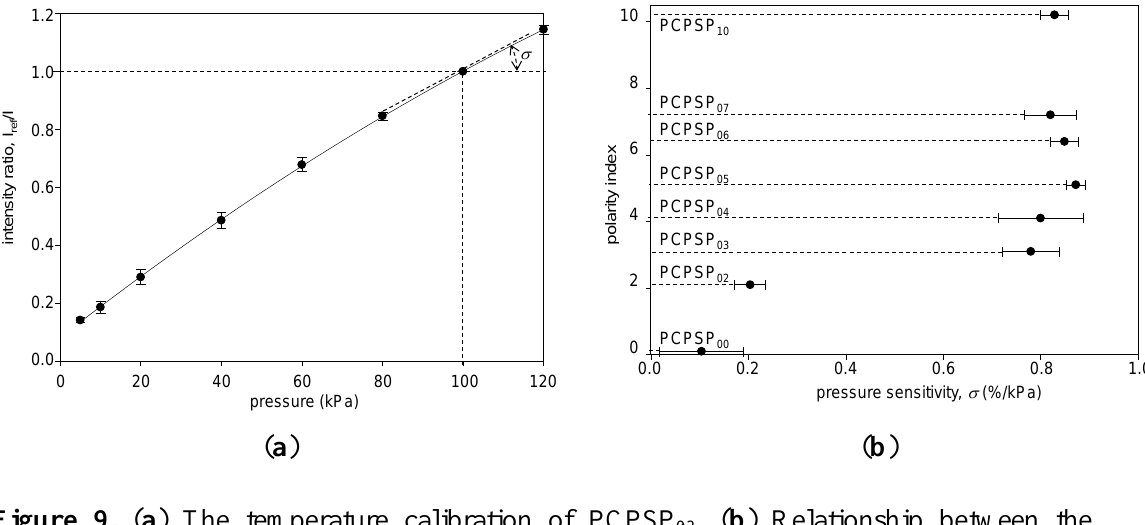
. ( b ) Relationship between the 03